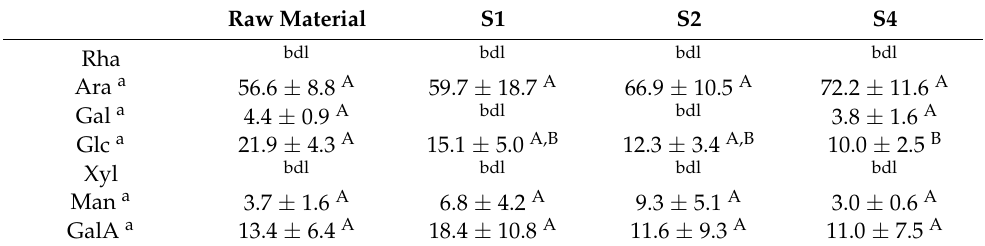
Table A7. Monosaccharide composition (mol%) of low-molecular weight soluble dietary fiber (LMW- SDF) of enzymatically treated apple pomace (raw and extruded) after TFA hydrolysis (mean value ± standard deviation, n = 3) Rha: rhamnose, Ara: arabinose, Gal: galactose, Glc: glucose, Xyl: xylose, Man: mannose, GalA: galacturonic acid, S1: only transport elements, S2: two reverse elements, S4: two reverse elements and a kneading block, bdl: below detection limit.